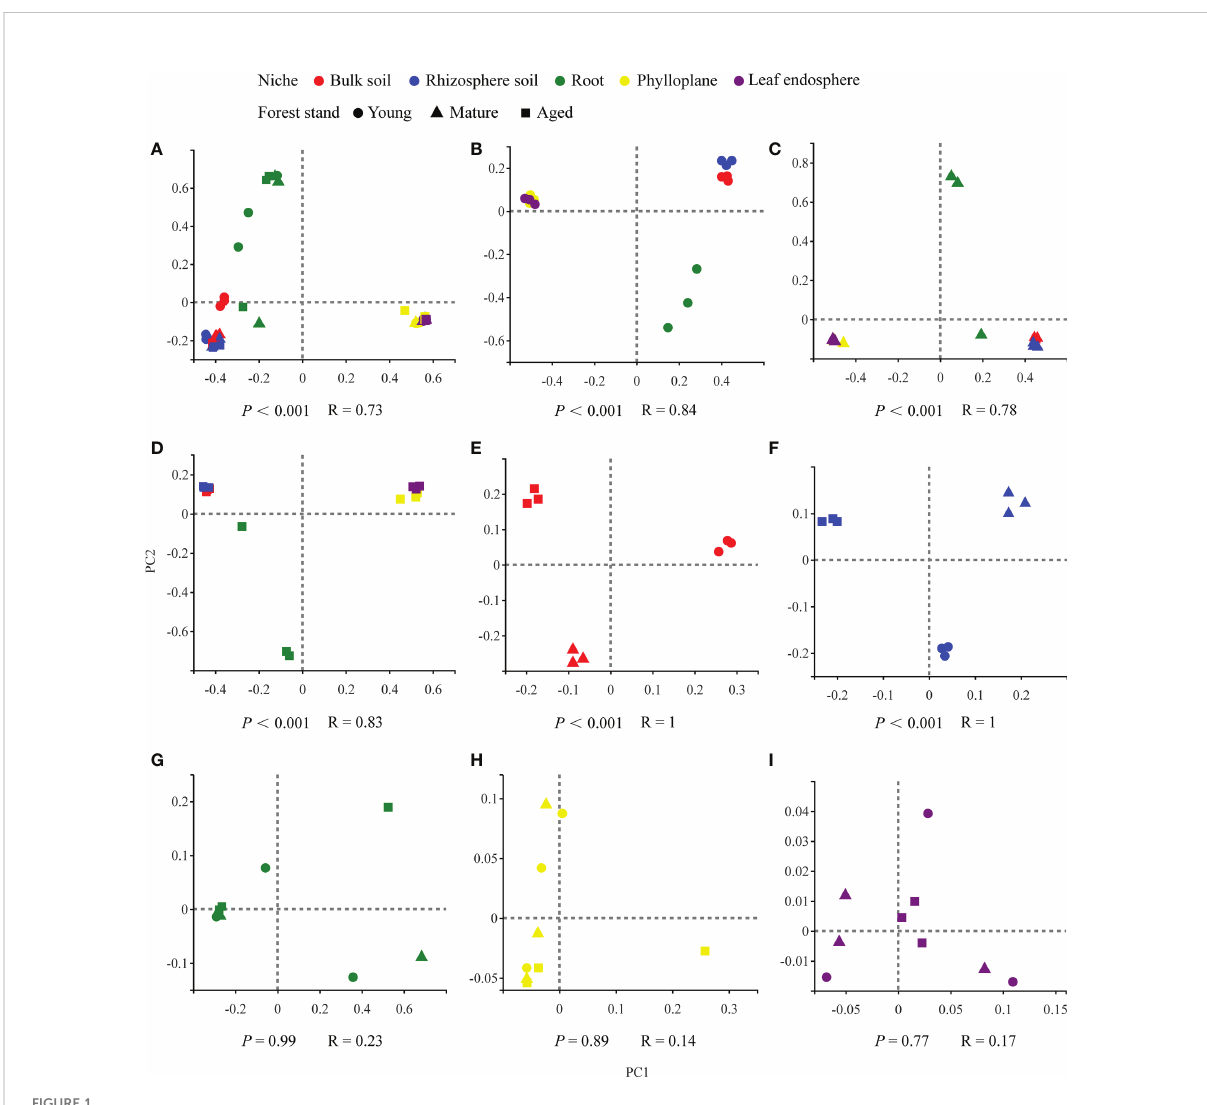
FIGURE 1 PCoAordinations basedonselected distancematrices ofbacterial communities in eachcompartment nichesfromsamples ( n = 45). (A) all samples; (B) young forest stand; (C) matureforest stand; (D) aged forest stand; (E) bulk soil; (F) rhizosphere soil; (G) root; (H) phylloplane; (I) leaf